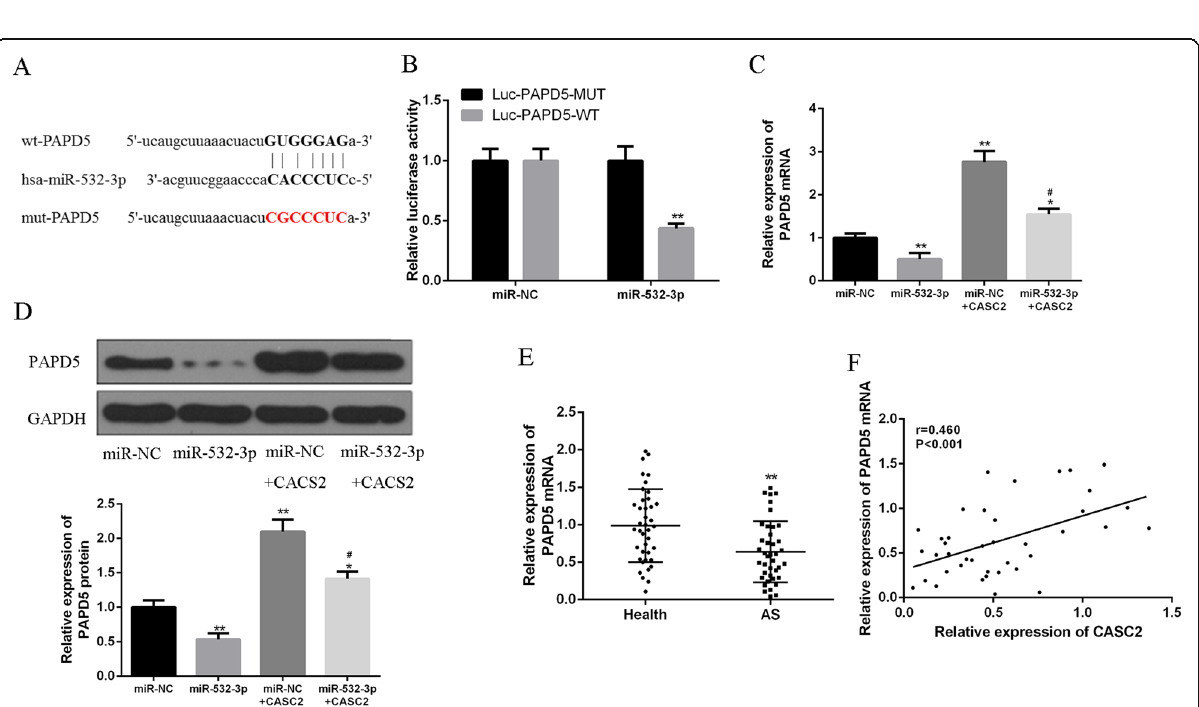
Fig. 3 CASC2 sponged and sequestered miR-532-3p to up-regulate the expression of PAPD5. a The common binding sequences of miR-532-3p and PAPD5 by Targetscan analysis. b The luciferase activities of VSMCs co-transfected with miR-532-3p mimic and PAPD5-WT or PAPD5-MUT. c qRT-PCR for the expression of PAPD5 in VSMCs co-transfected with miR-532-3p mimic or miR-NC, and CASC2 or control. d Western blotting for the expression of PAPD5 protein in VSMCs co-transfected with miR-532-3p mimic or miR-NC, and CASC2 or control. e qRT-PCR for the expression of PAPD5 in serum of AS patients and healthy volunteers. f Pearson ’ s analysis of CASC2 and PAPD5 in serum of AS patients (r = 0.460, P < 0.001). * vs. control group, # vs. miR-532-3p mimics group. ** P < 0.01, ## P <